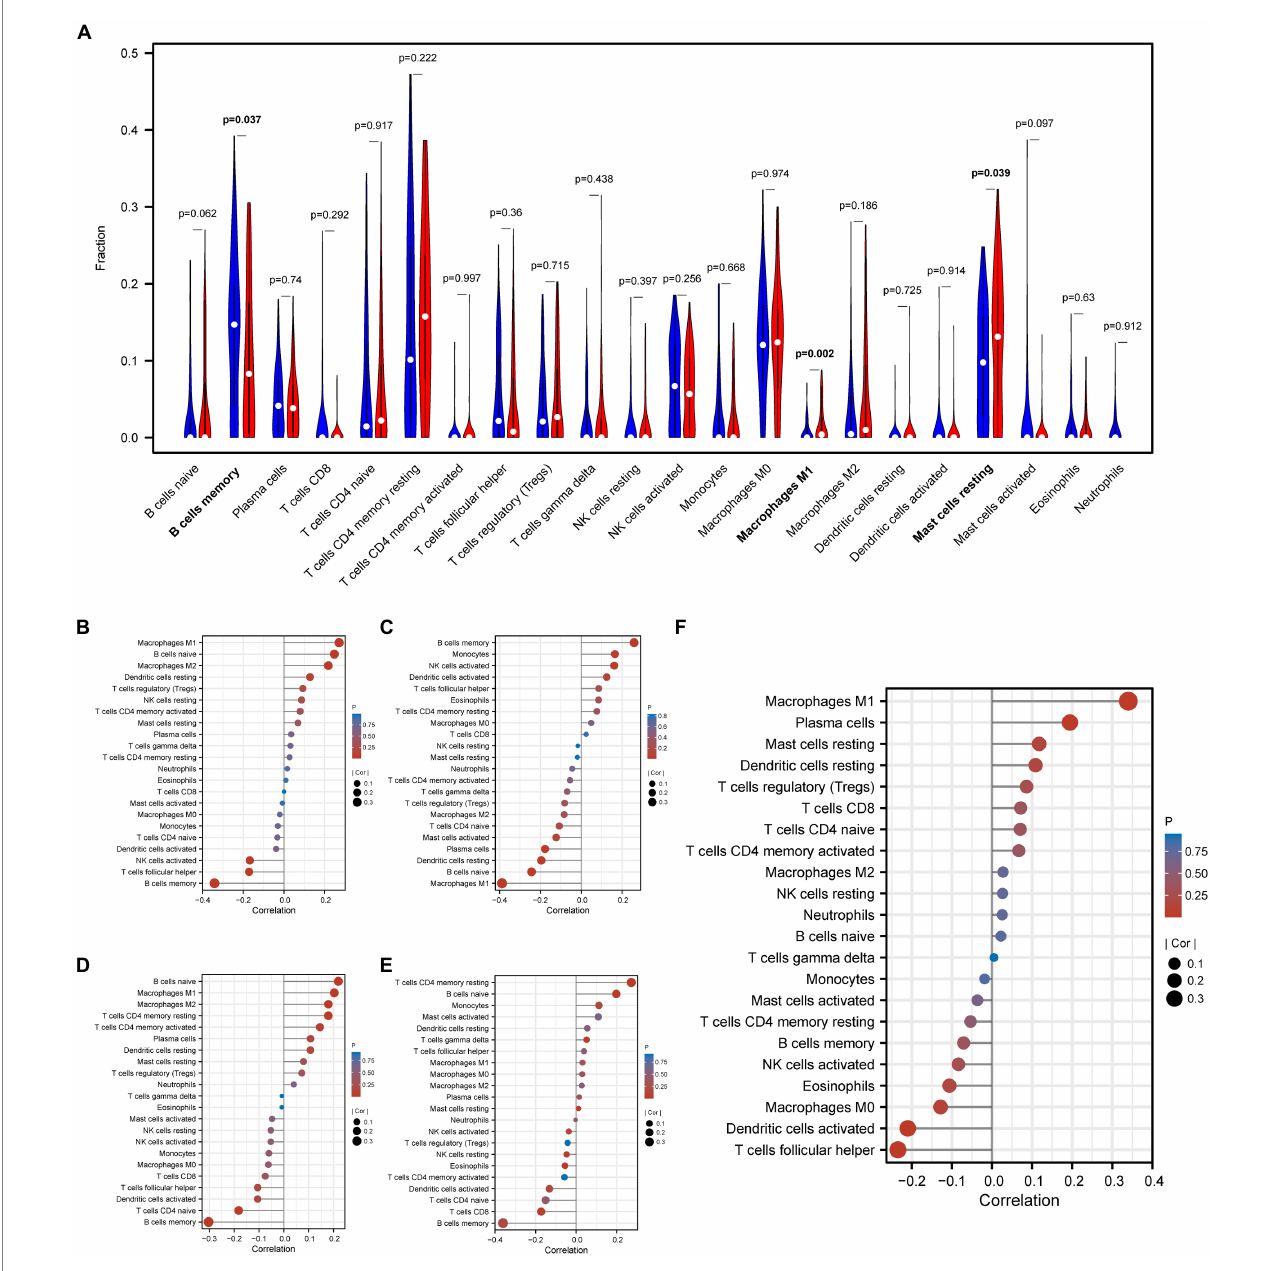
FIGURE 7 Evaluation and visualization of immune cell infiltration and the correlation between FRGs and lncRNAs and infiltrating immune cells. (A) Violin diagram of immune cell infiltration difference of 22 types of immune cells in AD and normal samples. (B) Correlation between EMX2OS and infiltrating immune cells. (C) Correlation between miR7-3HG and infiltrating immune cells. (D) Correlation between NIFK-AS1 and infiltrating immune cells. (E) Correlation between VAC14-AS1 and infiltrating immune cells. (F) Correlation between LRRFIP1 and infiltrating immune cells. FRGs, ferroptosis-related genes; lncRNAs, long non-coding RNAs; AD, Alzheimer’s